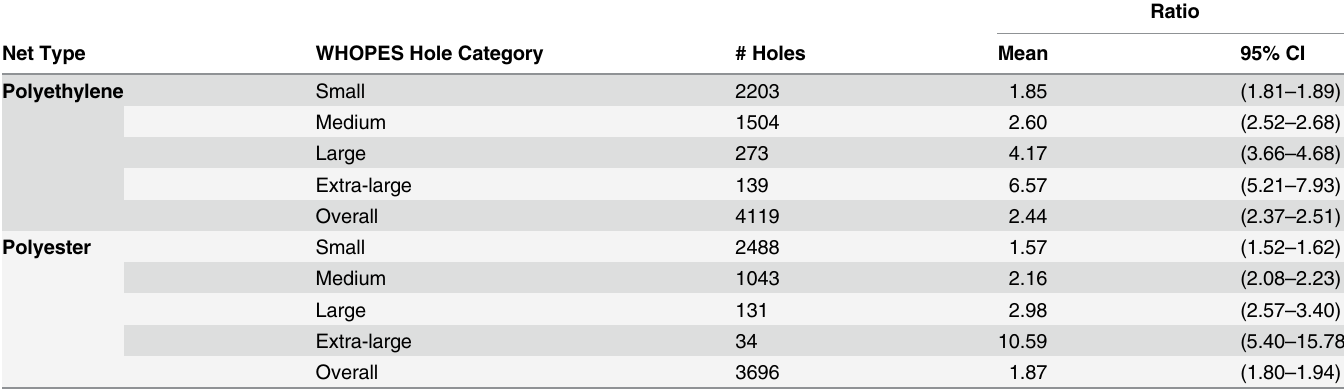
Table 5. Ratio of length of major axis to the minor axis of a hole by net brand and WHOPES hole size categories.